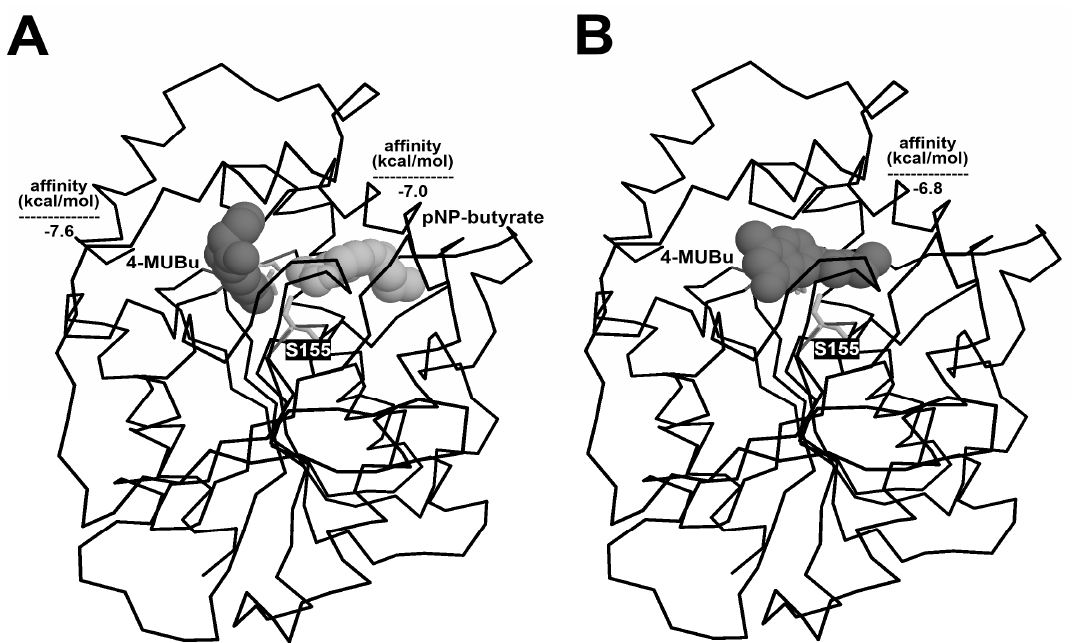
Figure 2. Docking analysis with binding free energies (shown as kcal mol − 1 ) of complexes between EST2 and substrates. Trace representation of EST2 backbone (black), residues in the catalytic site are represented as stick in gray, the substrates MUBu (dark gray) and pNitrophenyl-butyrate (gray) are depicted as a van der Waals surface (WDV) representation. ( A ) Accommodation of 4-MUBu in the alcohol pocket of EST2, with respect the pNitrophenyl-butyrate bonding to the acyl one; and ( B ) arrangement of 4-MUBu in the catalytic site with less affinity with respect to the alcohol pocket.